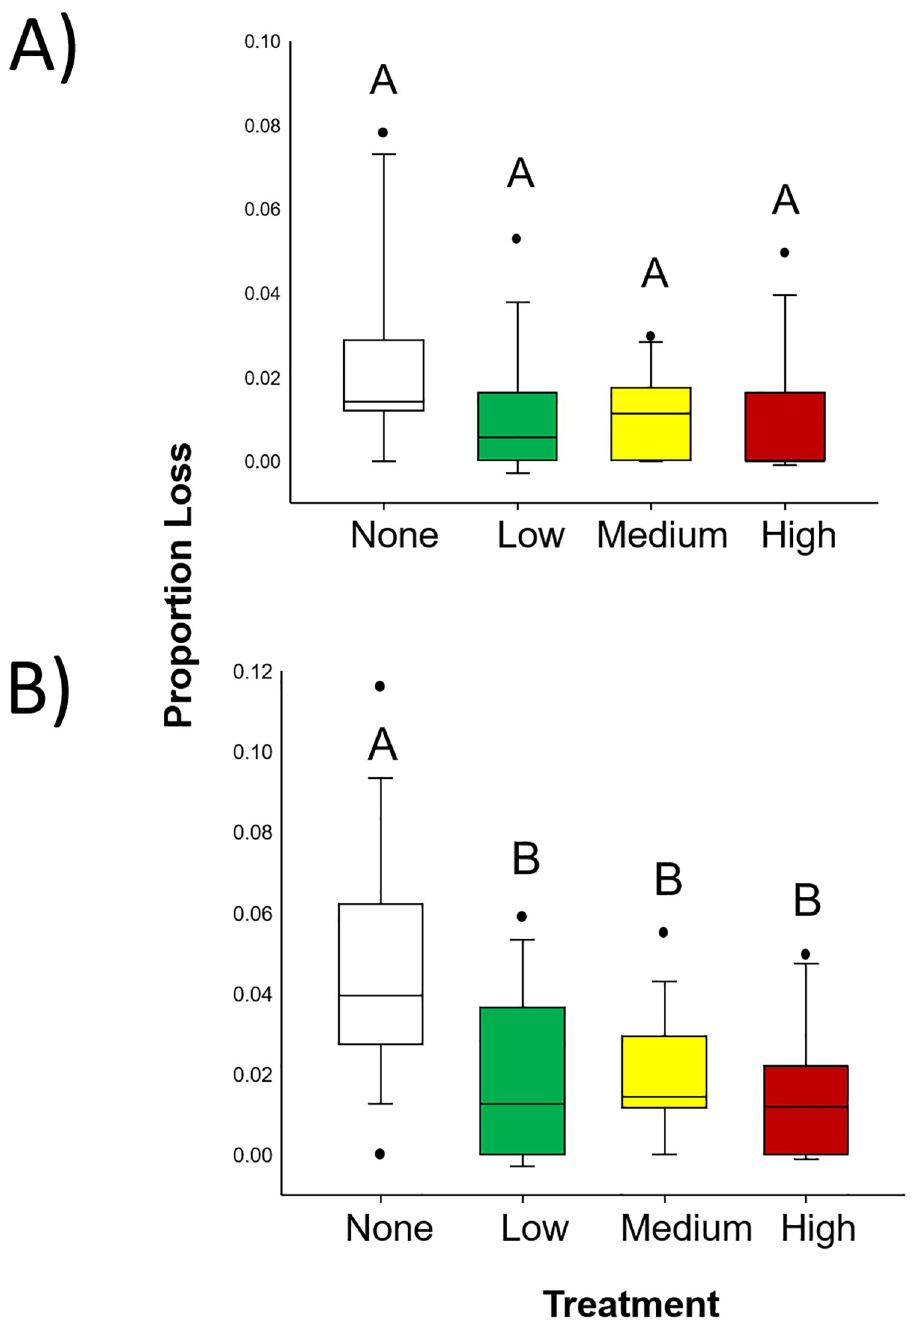
Fig 5. Results from Experiment 2: Amphipods. Foraging rate experimental results indicating consumption by amphipods ( G . mucronatus ) over 24 (A) and 48 (B) hour experimental durations. Colors represent plants grown under one of 4 different oil conditions: no (white), low (green), medium (yellow), and high (red). Different letters indicate statistically significant differences.